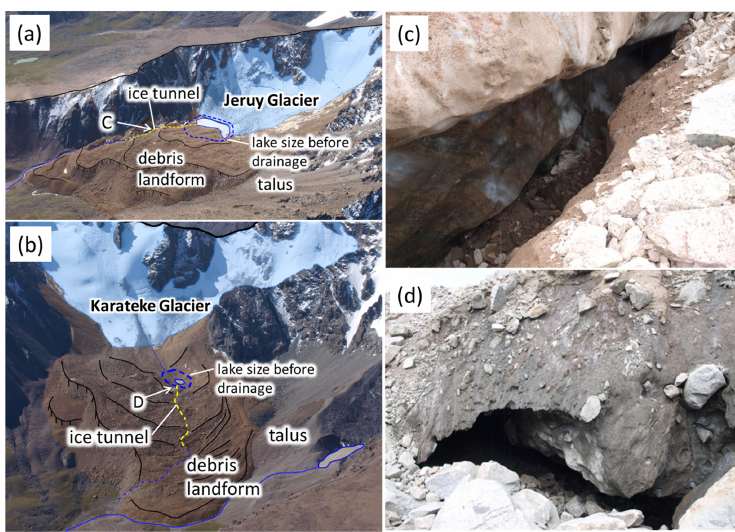
Figure 5. Surface details of the Jeruy and Karateke Glaciers (locations in Fig. 1). In (a) and (b) , the blue dashed lines show the lake size before drainage (Photo: 21 August 2014). Yellow dashed lines locate ice-tunnels. (c) The ice tunnel in the middle of the debris landform at the Jeruy Glacier (Photo: 9 August 2014). (d) The entry point of the ice tunnel at the front of the Karateke Glacier (Photo: 8 August 2014). The glacial lake with glacier contact expanded into the Jeruy Glacier, and the glacial lake without glacier contact developed in front of the Karateke Glacier.